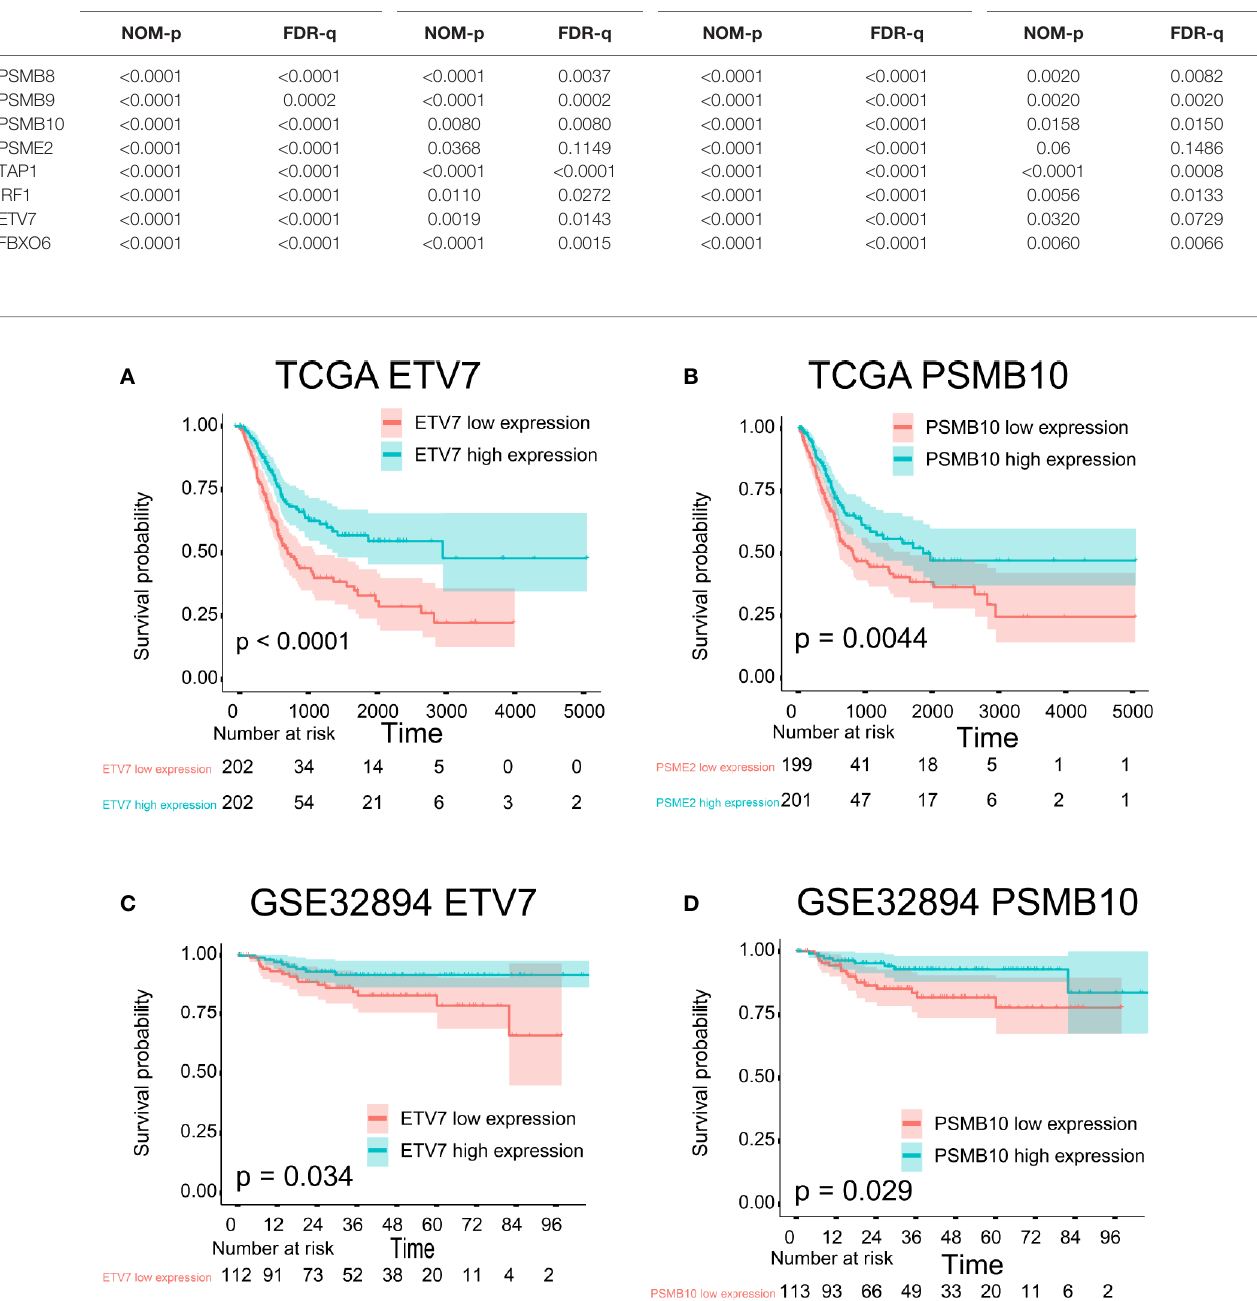
TABLE 4 | The results of GSEA analysis. Antigen processing and presentation Chemokine signaling pathway Nature killer cell mediated cytotoxicity T cell receptor signaling pathway